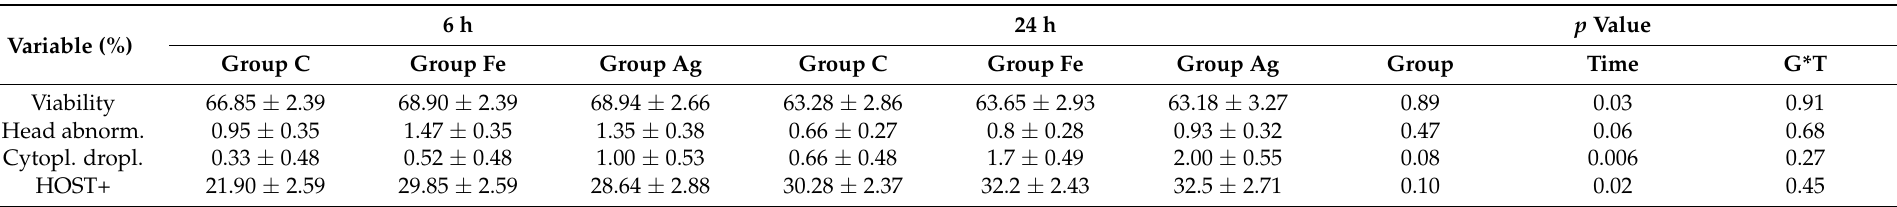
Table 2. Sperm quality of liquid ram semen ( n = 21), (LSmeans ± SEM) preserved at 15 ◦ C for 6 h and 24 h post treatment with Fe 3 O 4 and Ag/Fe nanoparticles (NPs). Variable